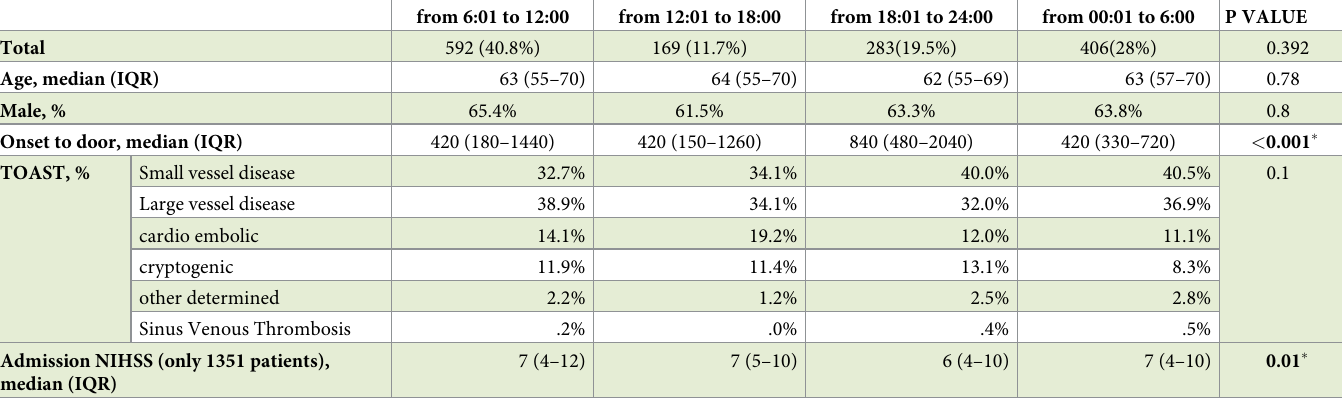
Table 2. Characteristics of patients according to time of stroke onset.